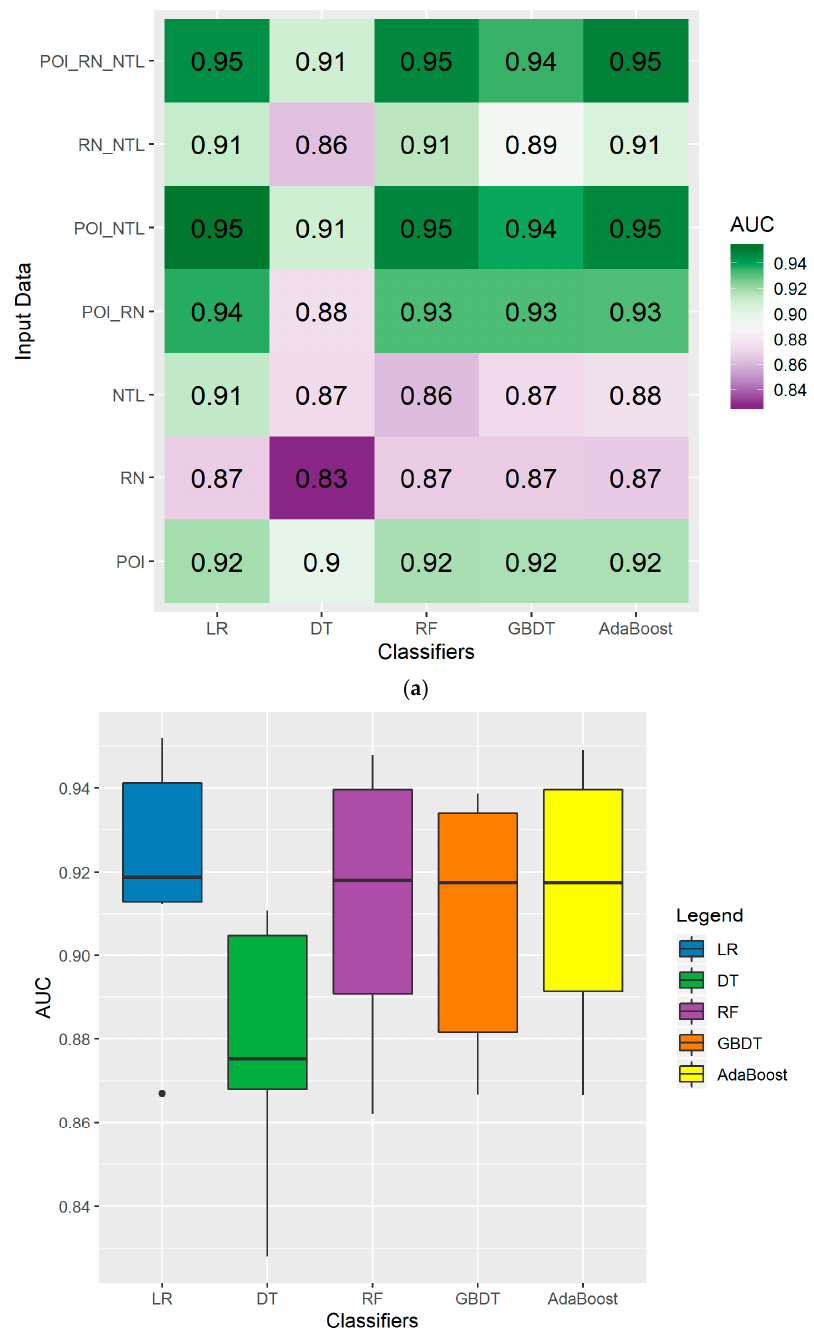
Figure 10. The ( a ) heat map and ( b ) boxplot of AUC for 35 combinations between the five classifiers and seven types of input data using the BAIC.